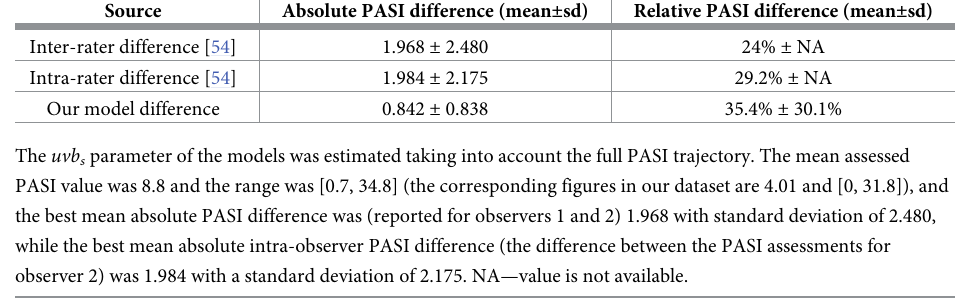
Table 3. Simulation of PASI outcomes by our ODE model that are comparable to PASI assessments made by for- mally trained physicians and nurses. Source